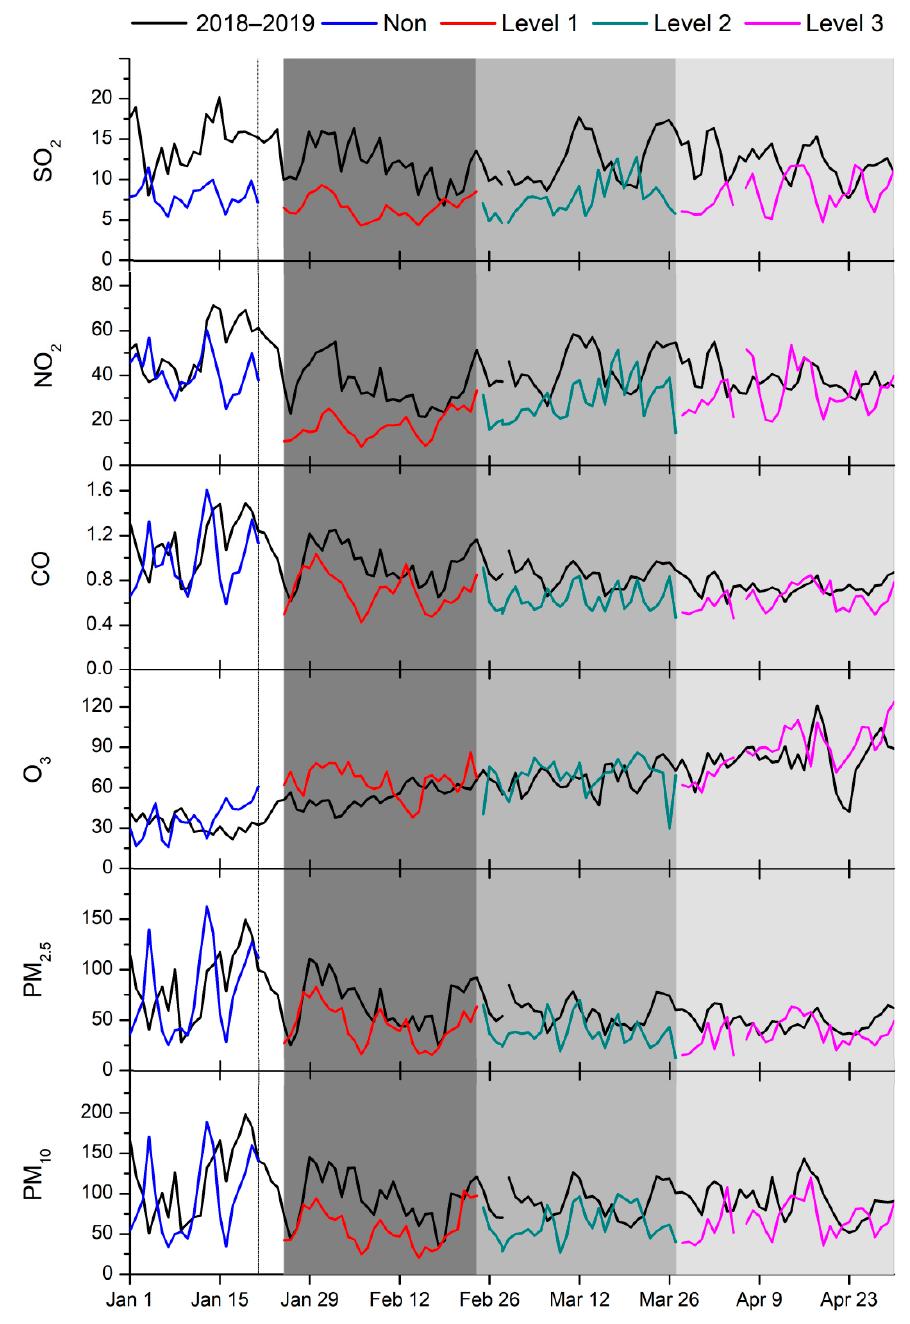
Figure 3. Daily variations of pollutant concentrations under different PPC levels.The shadows of dark grey, medium grey and light grey represent the L1, L2 and L3 period dark grey, medium grey and light grey represent the L1, L2 and L3 period respectively.